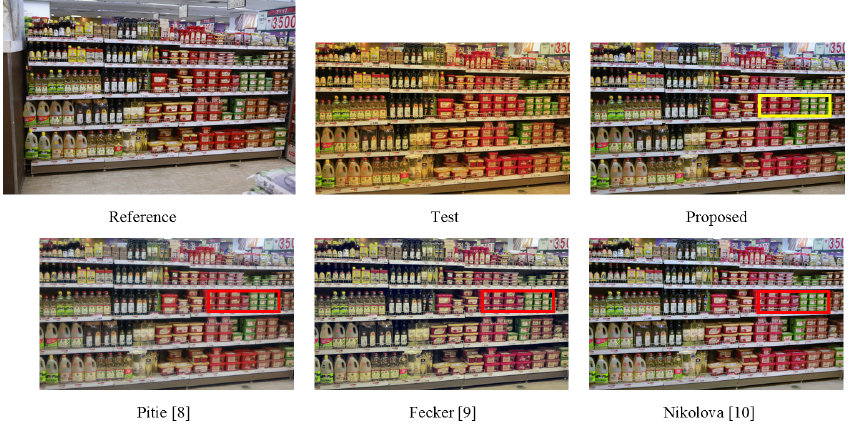
Figure 10. Comparison for the real image pair. Image Source: courtesy of the authors and databases referred on